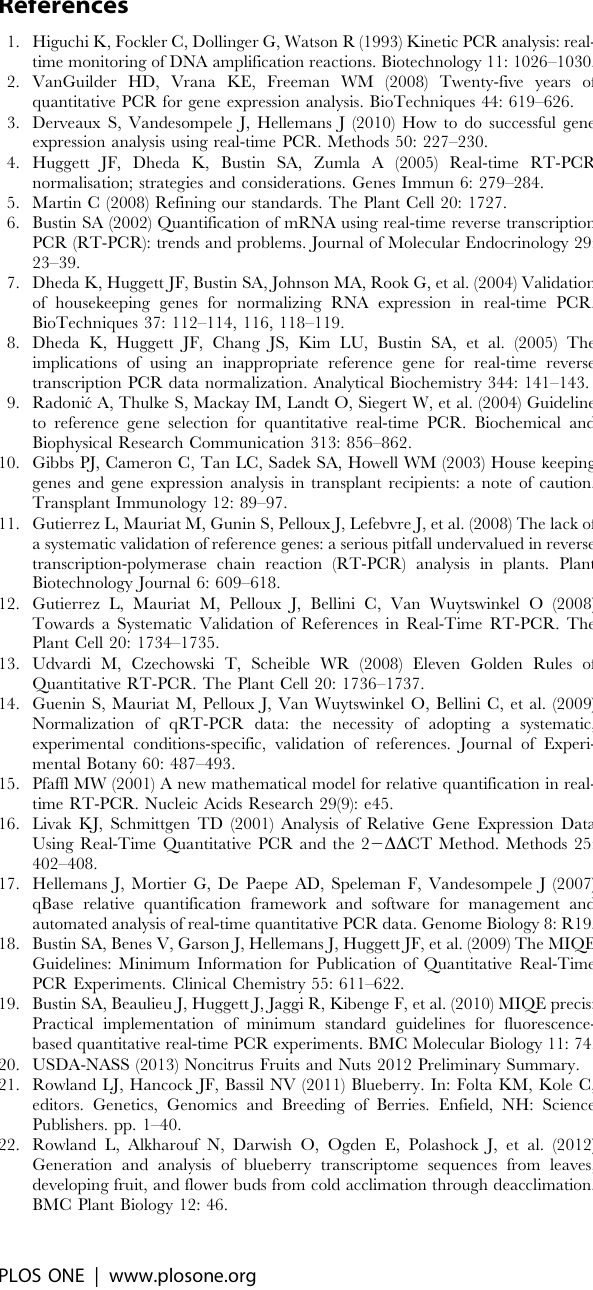
Figure S2 Dissociation curves for 12 representative PCR products. Figure S3 geNorm ranking of 10 reference genes from blueberry leaves. Vertical numbers at the top indicate the CV values of the reference genes involved in the normalization. References showing highly stable expression ( M values , 0.5) are represented as orange bars.